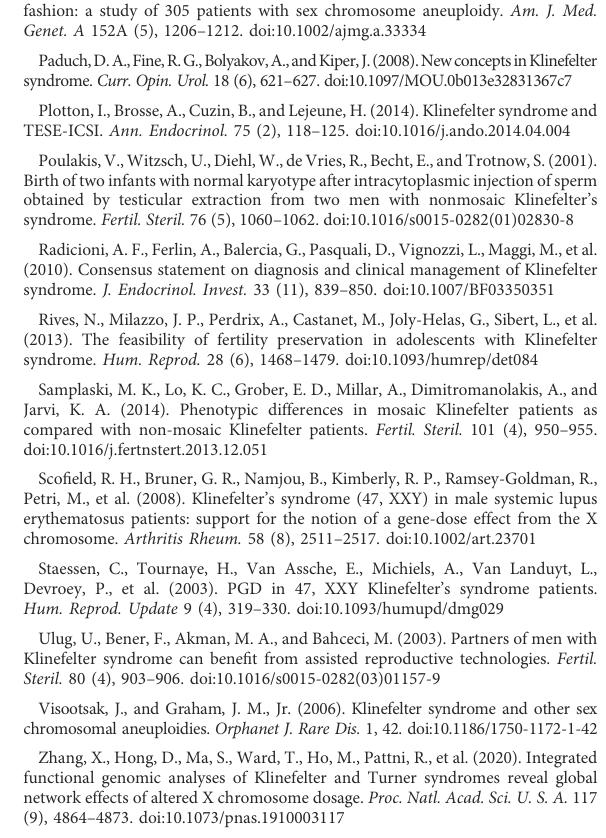
SUPPLEMENTARY FIGURE S1 Karyotype result of the patient. The G-banding method was used to detect the karyotype, and the patient's karyotype was 47, XXY. SUPPLEMENTARY FIGURE S2 Testicular B-ultrasound pictures and volume calculation results of the patient. The formula for calculating testis volume from b-ultrasound images is 0.71 × length × width × height. Using this formula, we calculated that the volumes of the patient ’ s left and right testes were 6.6 ml and 7 ml,